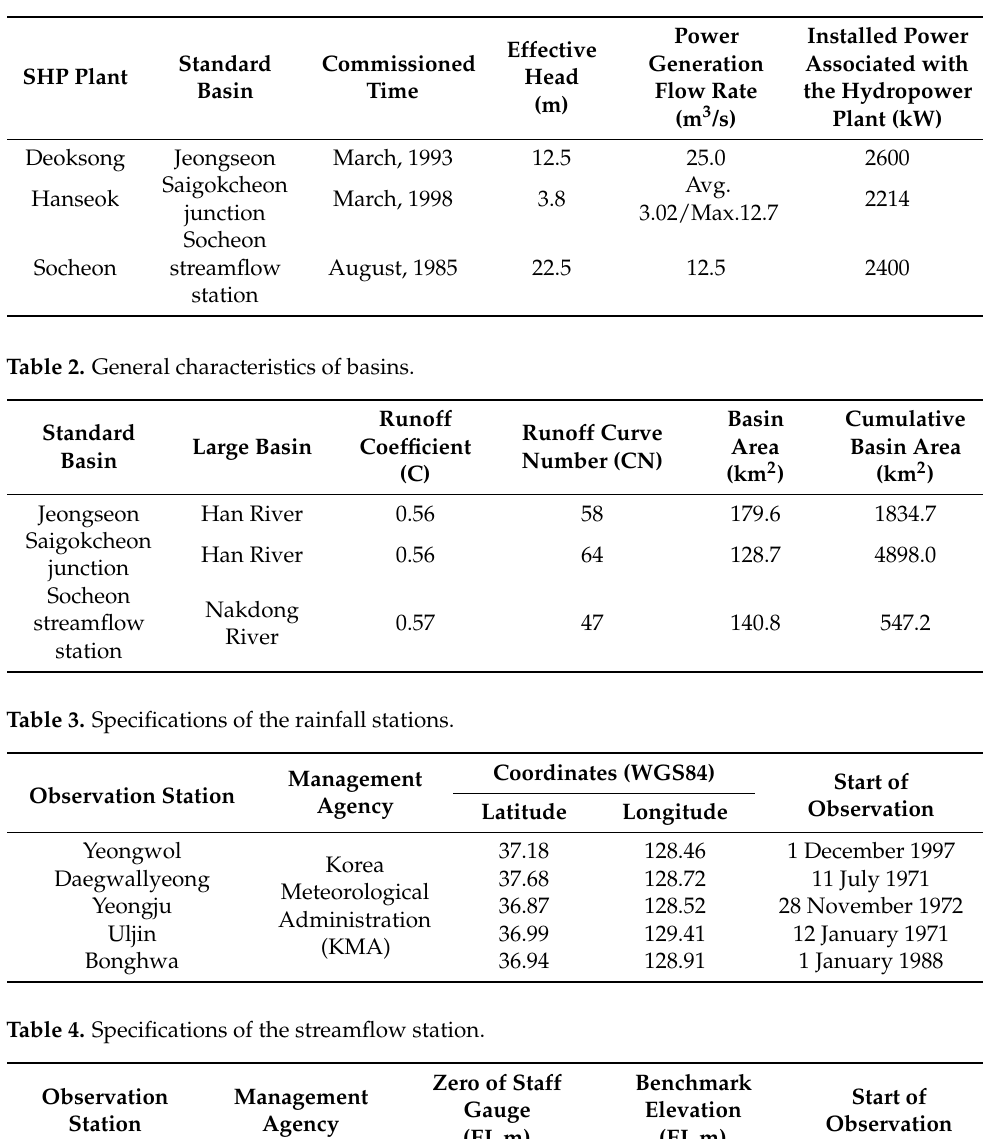
Table 1. Information on small hydropower (SHP) plants of target basins.